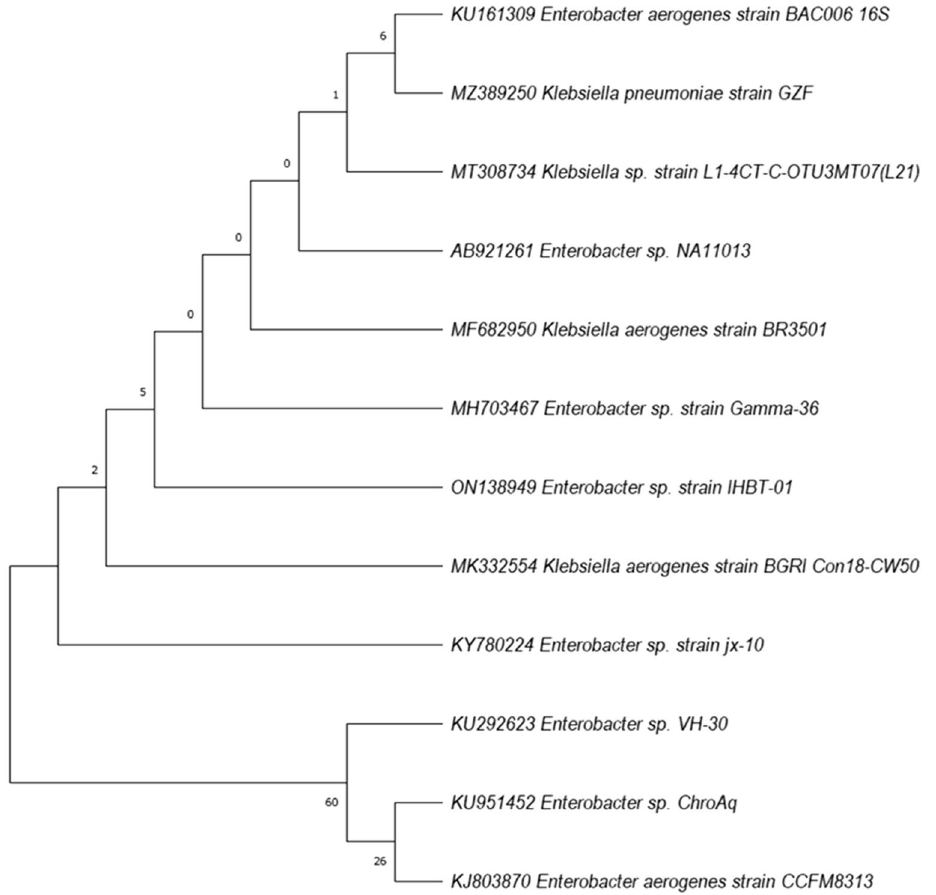
Figure 4. The evolutionary history was inferred by using the Maximum Likelihood method and Tamura-Nei model. The 16S rRNA gene sequences showing relationships between strain Enterobacter sp. and closely related members of the genus Enterobacter . Numbers at nodes indicate levels of bootstrap support based on a neighbor- joining analysis of 1000 resampled datasets; only values above 50% are